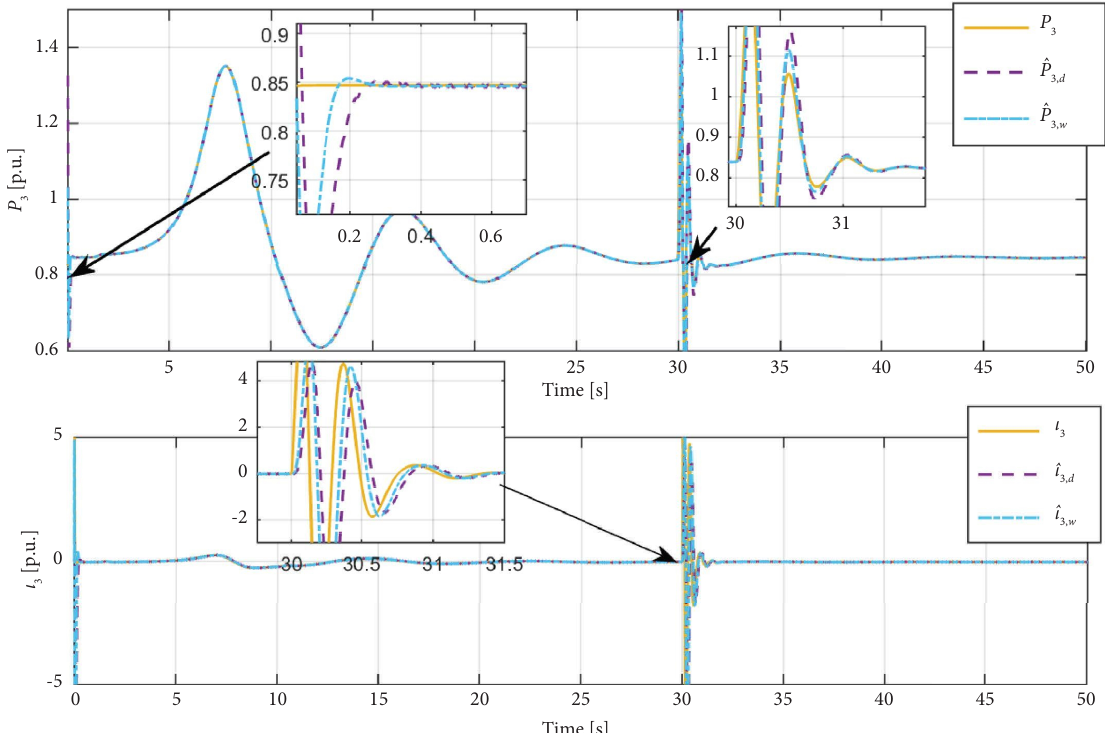
Figure 7: Comparison between the L-D GE estimators: the electrical power and nonlinear interconnection term of generator